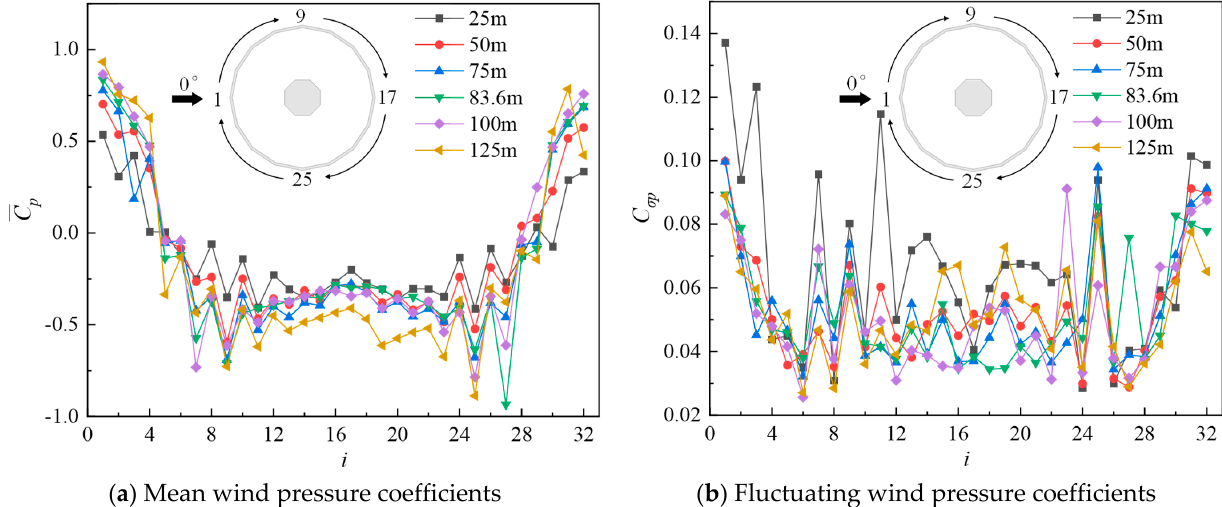
Figure 27. Wind pressure coefficients at each measuring point on the outer surface of the grid struc- ture at a 0° wind direction angle.